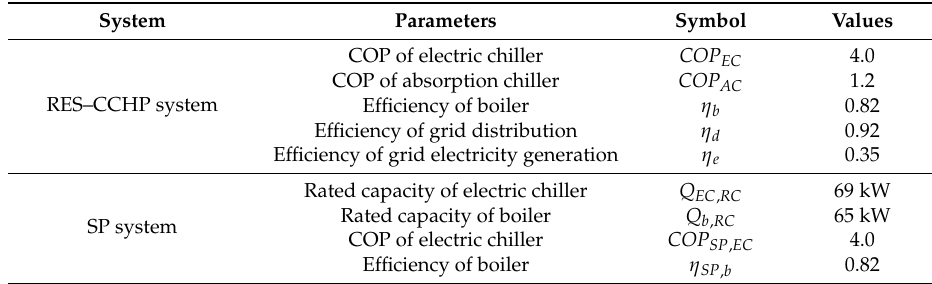
Table 4. Characteristic parameters of the renewable energy sources integrated combined cooling, heating, and power (RES–CCHP) system and SP system.